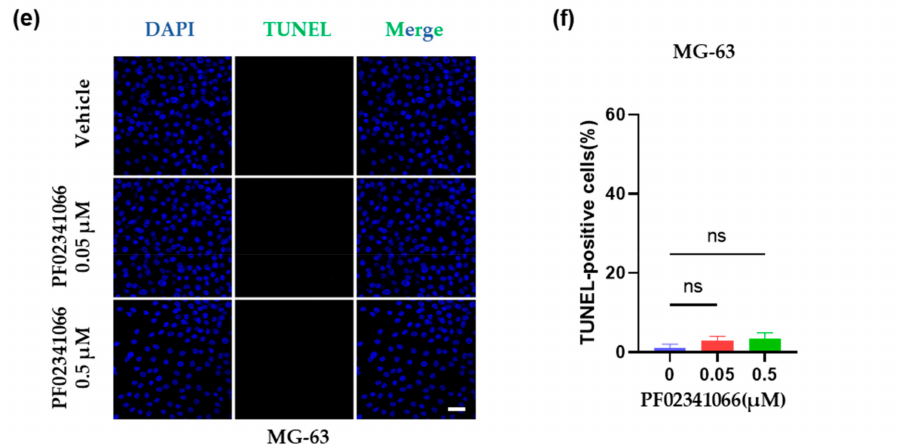
Figure 1. c-Met inhibitor PF02341066 showed a dose-dependent inhibition of OS cells proliferation and survival. ( a ) MNNG/HOS and MG-63 cells were cultured in the presence of the indicated concentrations of PF02341066 for 48 h prior to fixation and crystal violet staining. Crystal violet staining was quantified by solubilizing the fixed dye and assessing the absorbance at 570 nm. Values indicated were normalized to DMSO control. Mean ± SEM, three independent experiments, each with n = 3. The concentration of drug needed to reduce plaque numbers by half (IC50) was calculated by fitting the data to a linear regression model using Prism software (GraphPad Prism Software, Inc., La Jolla, CA, USA). ( b ) Western blotting analysis on the expression and the phosphorylation of c-Met in MNNG/HOS and MG-63 cells cultured in serum-free medium with the indicated concentrations of PF02341066 for 48 h. Detailed information about Western blot can be found at supplementary materials. ( c – f ) Representative images of the TUNEL assay. MNNG/HOS and MG-63 cells were cultured in the presence of the indicated concentrations of PF02341066 for 24 h. Apoptosis was determined by TUNEL assay (green channel) in samples either treated with PF02341066 or DMSO for control. DAPI (blue channel) was used to locate the nuclei of the cells. Scale bar = 50 µ m. ( d , f ) Quantitative analysis of TUNEL-positive MNNG/HOS and MG-63 cells. Mean ± SEM, three independent experiments, each with n = 3. *** p < 0.001, * p < 0.05, ns p > 0.05, by one-way